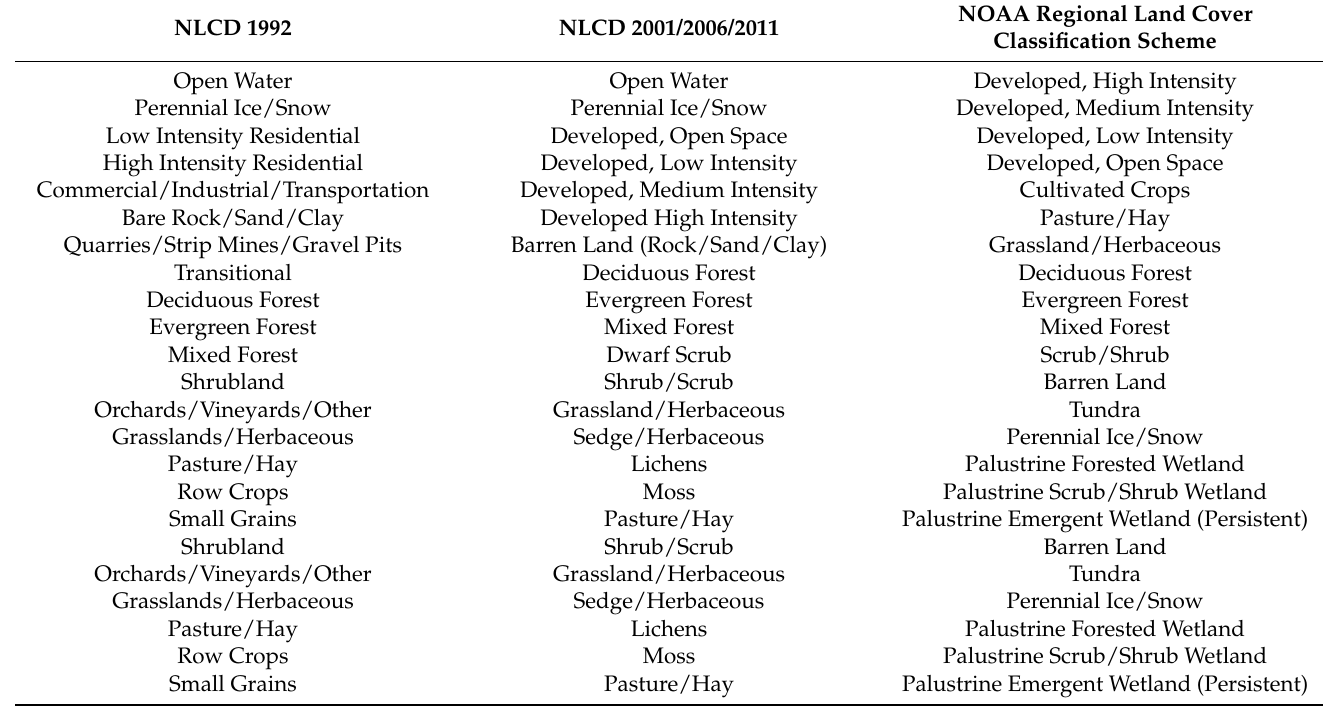
Table 4. Illustration on LULC classification systems and standards used for experiment.